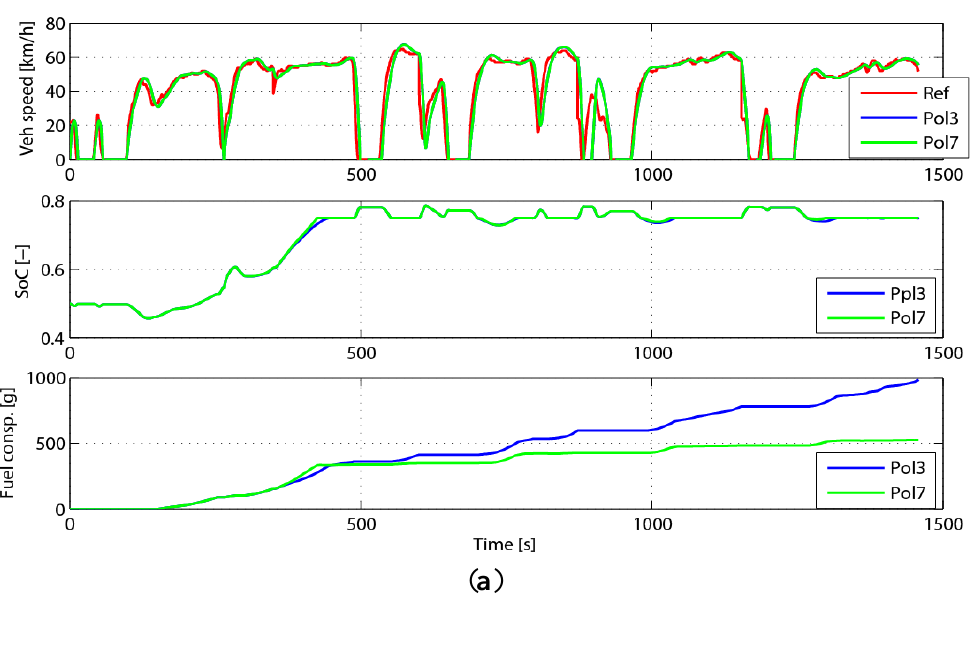
Figure 19. Comparison of the policy-3 and the policy-7 in the seventh segment driving data. ( a ) Vehicle speed, SoC and fuel-electricity consumption; ( b ) engine operating point